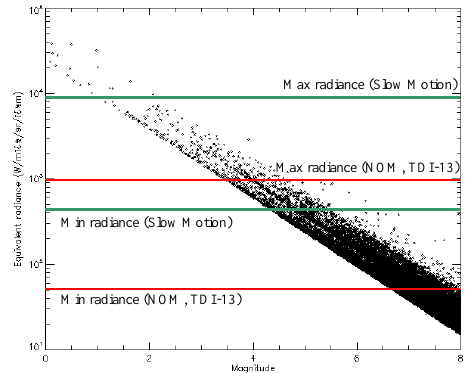
Figure 4 : equivalent radiance range (PA band) and stars magnitudes